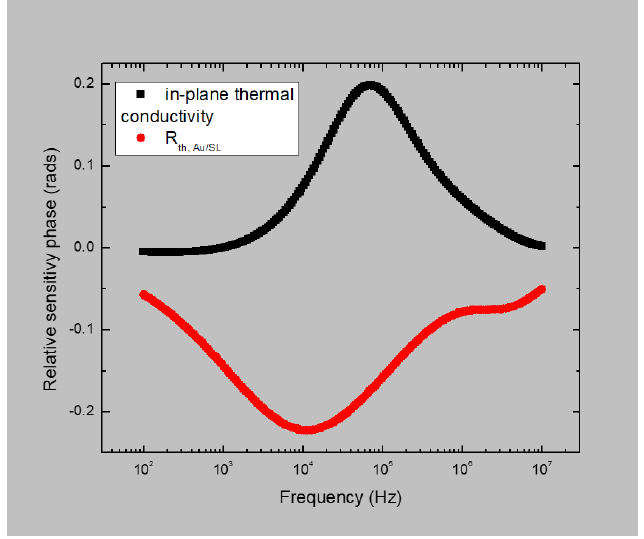
Figure 6. Phase relative sensitivities of model described by Equation (1) to the parameters (RAlGaAs/GaAs = 1.0 × 10 − 9 m 2 2 K/W, kAlGaAs = 12 W/mK, α AlGaAs=6 × 10 − 6 m 2 /s, L = 500 nm) and with other parameter values taken from Table 2.